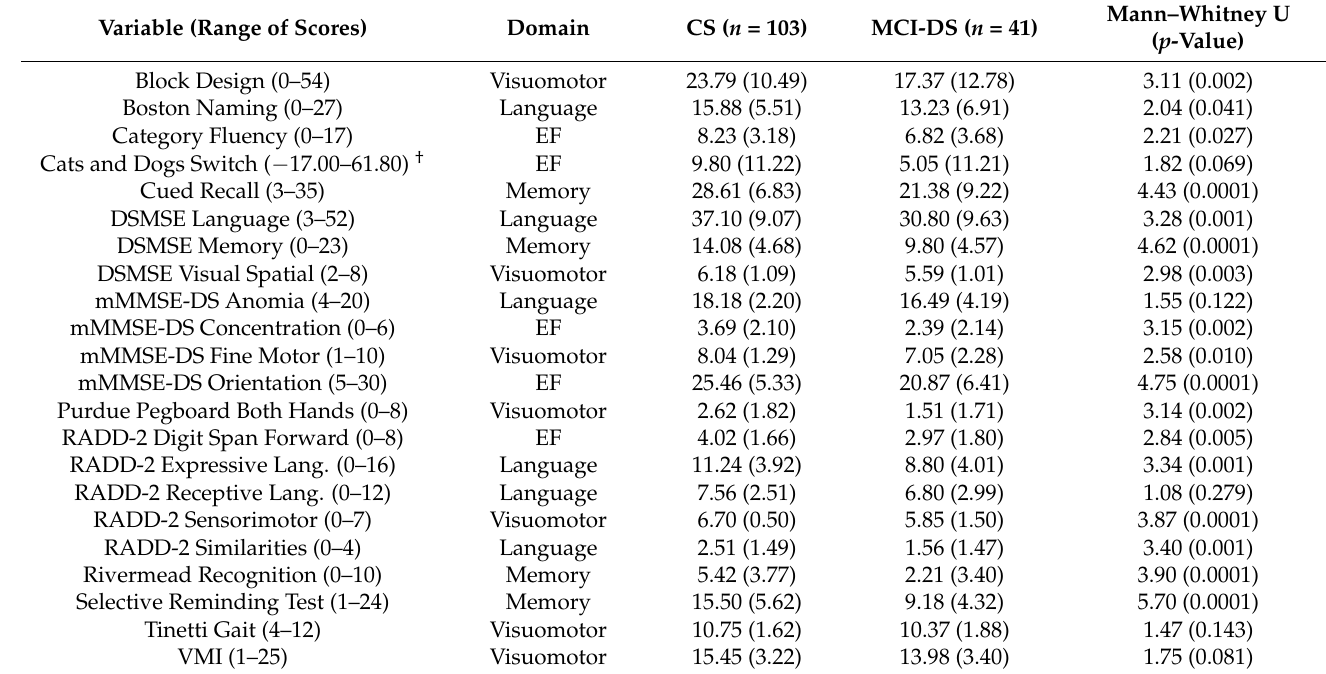
Table 2. Means and standard deviations of raw test scores by AD status and their hypothesized cognitive domain. Variable (Range of